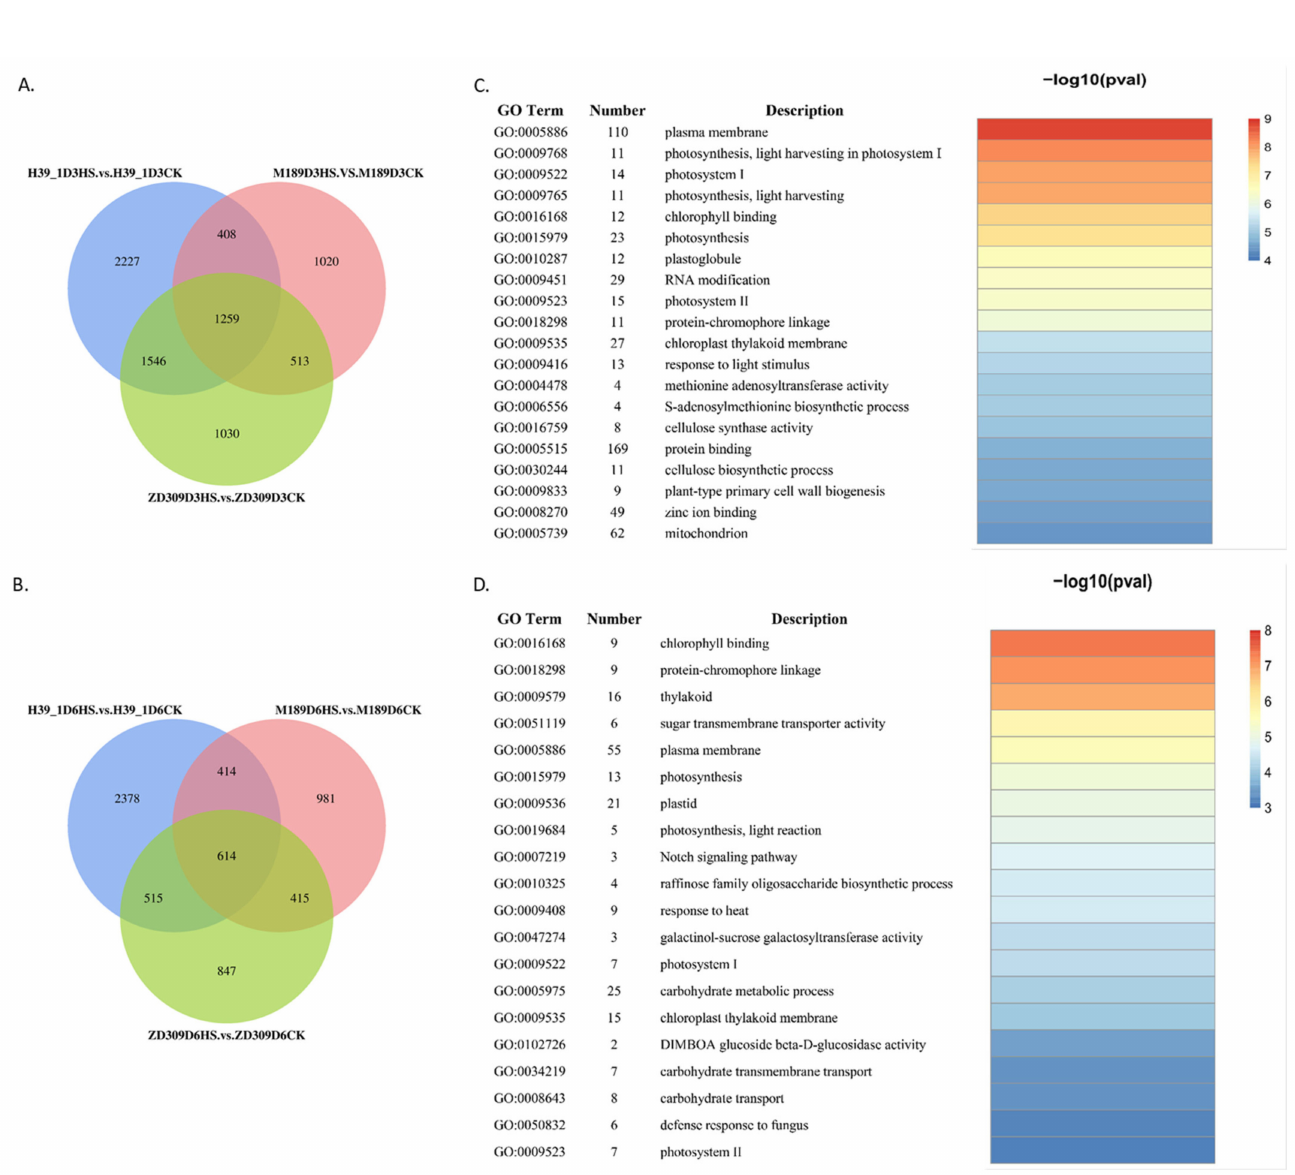
Figure 2. DEGs identifications and gene ontology analysis in transcriptomic data. ( A , B ) Numbers of the identified DEGs in the tested three genotypes under D3HS and D6HS treatments. ( C , D ) Gene ontology analysis for the conserved DEGs within ZD309 and its parental lines in H3HS ( C ) and H6HS ( D ) treatments. The heatmap presents statistical significance (log10-transformed corrected p -value) of GO terms